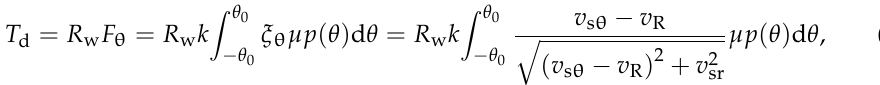
where R w is the contact radius; ξ θ is the circumferential coefficient; θ 0 is the contact area boundary of the stator and rotor; v s θ and v sr are the circumferential and radial speed of the stator particle, respectively; v R is the speed of the rotor; µ is the friction coefficient; and p ( θ ) is the normal contact pressure distribution function. The formula of the rotational motion is calculated by (3), according to the balance of the forces.